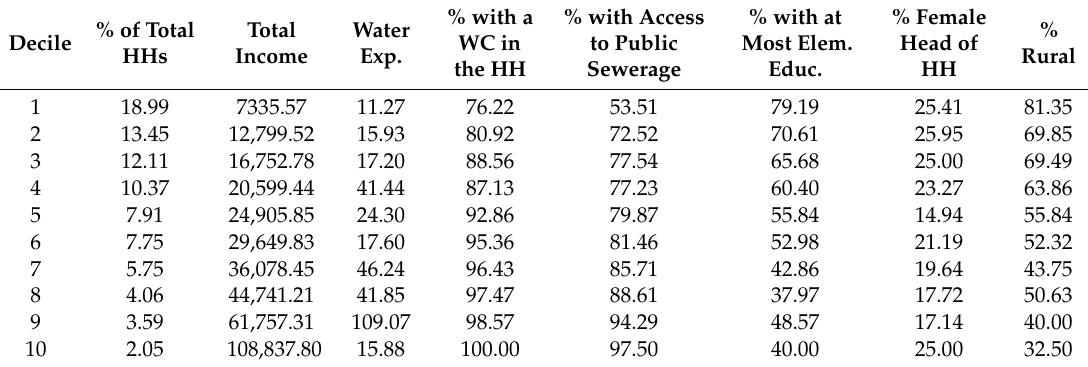
Table 8. Socioeconomic characteristics of Mexican households,